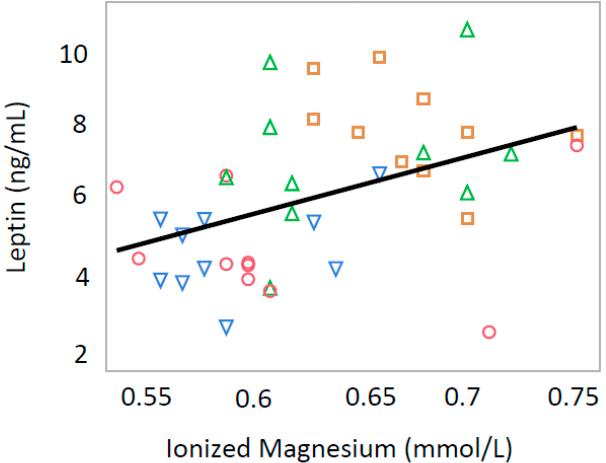
Figure 6. Relationship between serum leptin levels and serum ionized magnesium in both male and female rat offspring (R = 0.436, p = 0.0039). Green triangle, male offspring from control group; square, male offspring from Ca-deficient group; circle, female offspring from control group; blue inverse triangle, female offspring from Ca-deficient group.